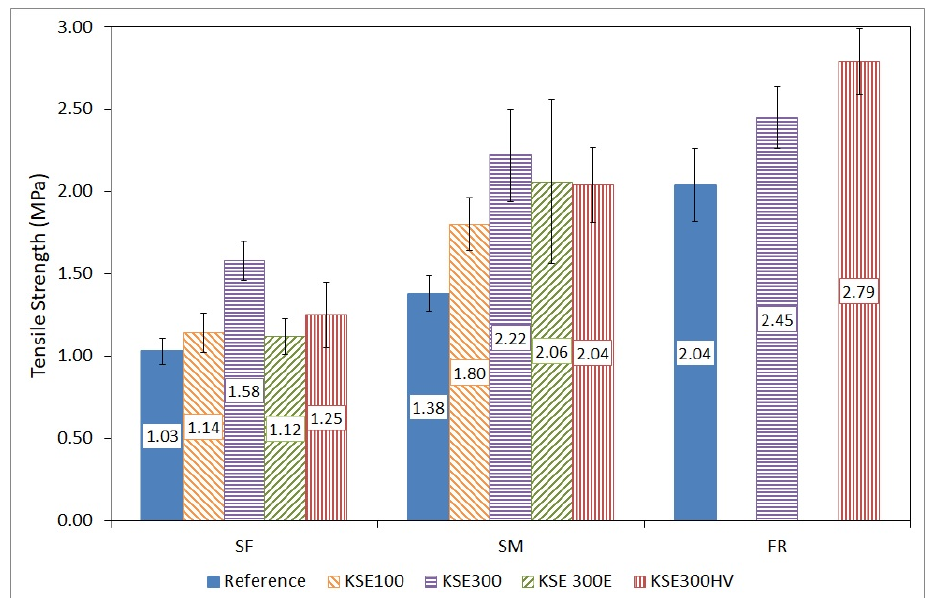
Figure 9. Tensile strength test results of reference samples vs. consolidated samples of SF, SM, and FR porous limestone (blue bars: reference values of the untreated samples, striped bars: treated samples). Table 5. Change in tensile strength after consolidation (ratio of consolidated and unconsolidated tensile strength).